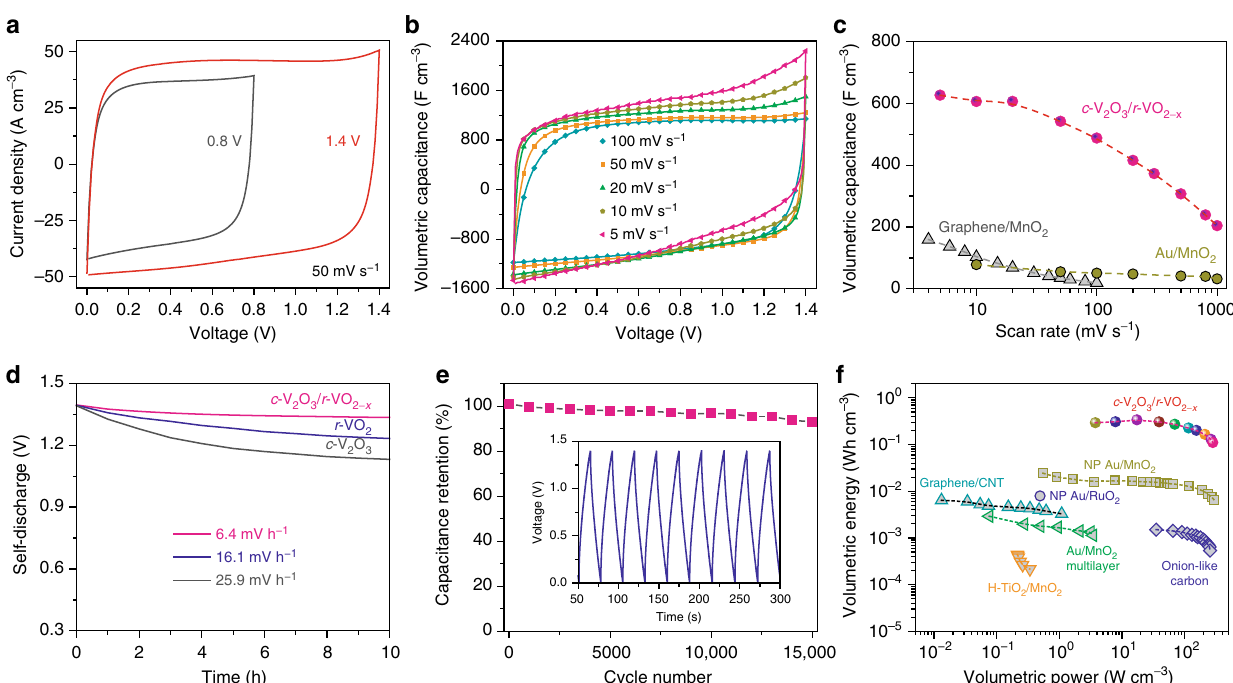
Fig. 5 Performance of aqueous symmetric pseudocapacitor devices in a wide voltage window. a CV curves for symmetric pseudocapacitors, with NP c - V 2 O 3 / r -VO 2 − x ( x = 0.22) as electrodes, in the voltage window extended from 0.8 to 1.4 V at a scan rate of 50 mV s − 1 in 1 M Na 2 SO 4 aqueous electrolyte. b CV pro fi les in a voltage window of 1.4 V for pseudocapacitors at different scan rates. c Volumetric capacitances of device of NP c -V 2 O 3 / r -VO 2 − x ( x = 0.22) electrode at various scan rates, comparing with the volumetric values of previously reported supercapacitors based on graphene/MnO 2 hybrid electrodes and Au/MnO 2 multilayers. d Self-discharge performances for symmetric pseudocapacitors based on NP c -V 2 O 3 / r -VO 2 − x , c -V 2 O 3 and r -VO 2 electrodes. e Cycling stability performance for NP c -V 2 O 3 / r -VO 2 − x -based pseudocapacitor in the voltage window of 1.4 V. Inset: Galvanostatic cycling curves collected at 130 A cm − 3 in 1 M Na 2 SO 4 aqueous electrolyte. f Ragone plot of volumetric power versus volumetric energy for pseudocapacitors based on total volumetric of NP c -V 2 O 3 / r -VO 2 − x in two electrodes, comparing with other electrochemical capacitors based on representative electrode materials such as onion-like carbon 5 and graphene/CNT hybrid 6 , as well as H-TiO 2 /MnO 2 19 , Au/MnO 2 multilayers 20 , NP Au/MnO 2 and NP Au/RuO 2